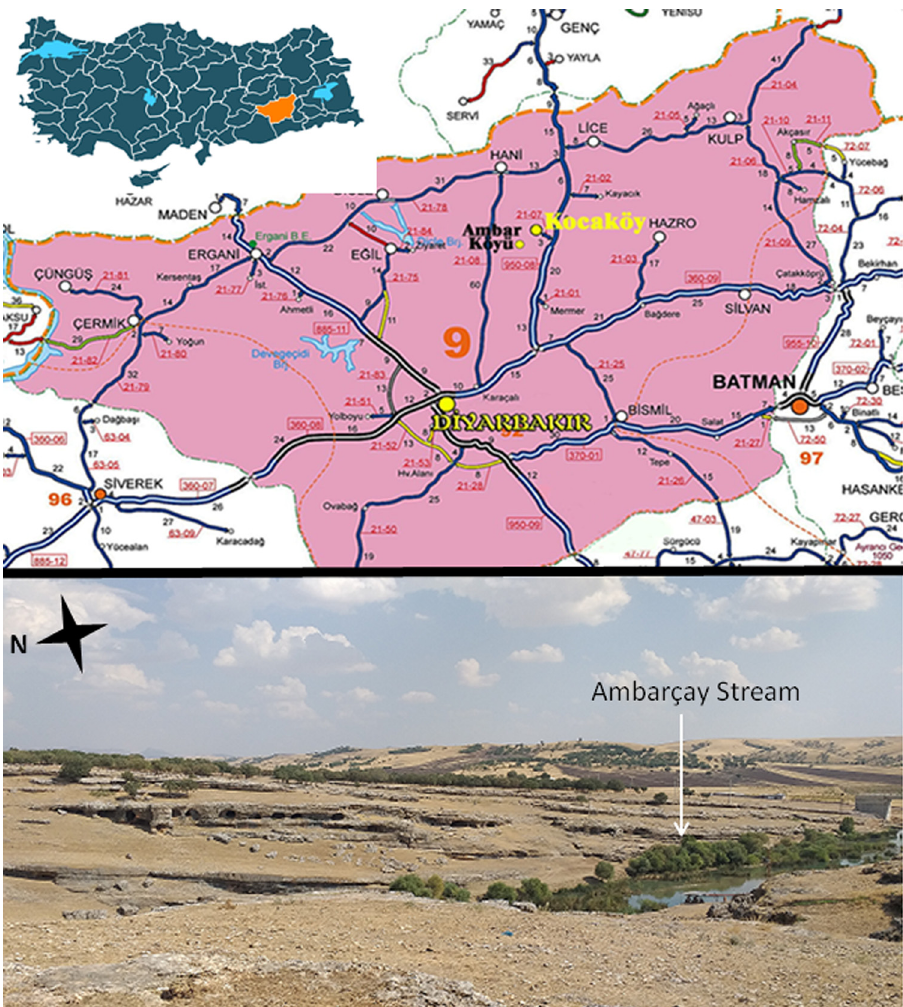
Figure 1: Location of Ambarçay village and view from the stream ( Source: Ambarçay Salvage Excavation Archive )